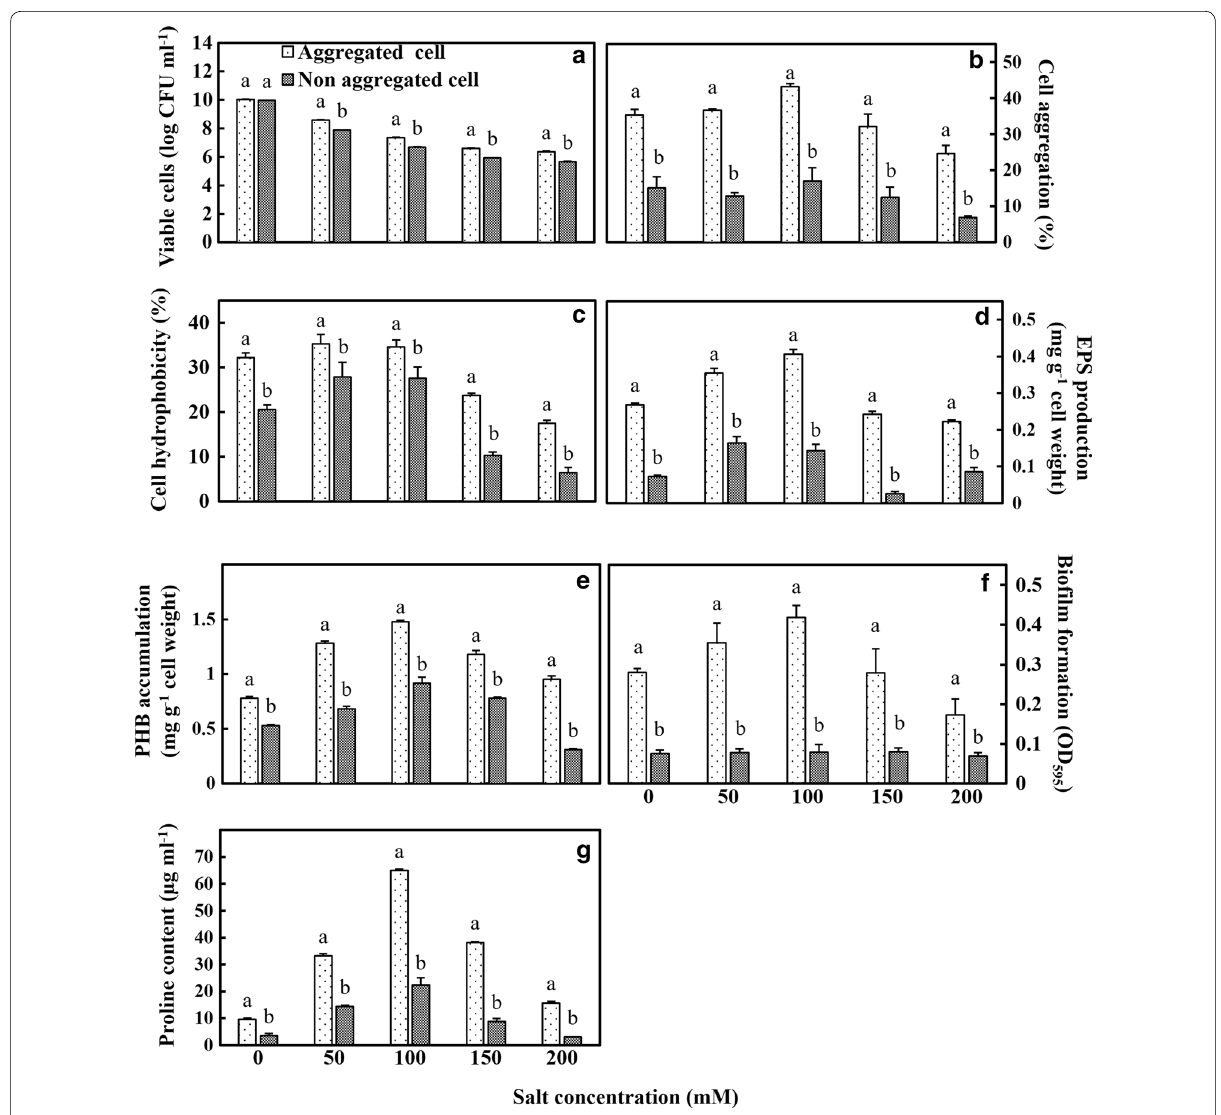
Fig. 3 The impact of different salt concentration on M. oryzae CBMB20 cells. a Survival. b Cell aggregation. c Cell hydrophobicity. d EPS production. e PHB accumulation. f Biofilm formation and g Proline accumulation. All data represents mean means analyzed using DMRT test ( P ≤